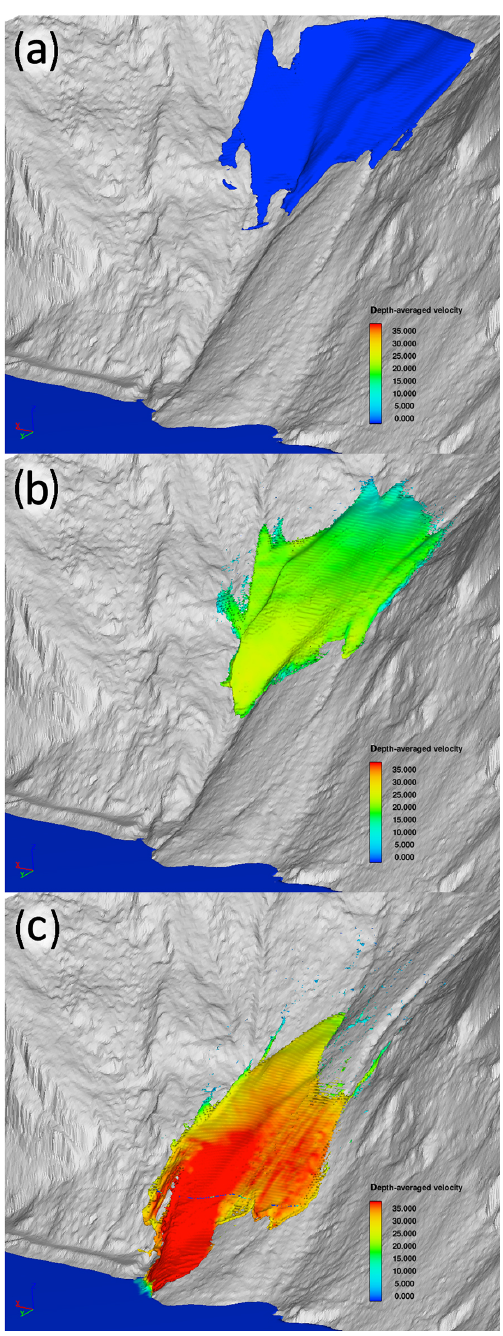
Figure 1. Exemplary results of a simulation with FLOW-3D (in- cluding added original stl-geometry) of a stopped and restarted avalanche model at (a) 0s, (b) 4s and (c) 8s after the restart and before it reaches the reservoir – coloured by the depth-averaged ve- locities in (ms − 1 ) with a range of 0–35ms − 1